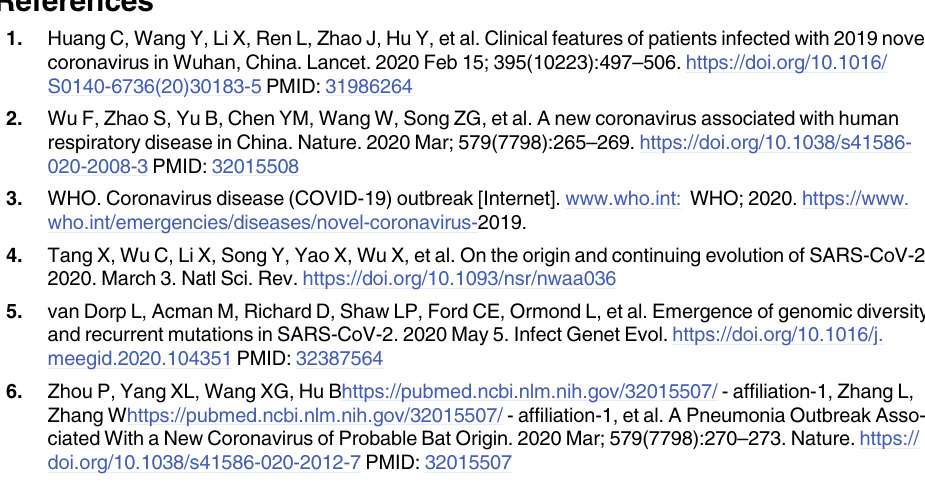
S4 Table. Evaluation of the sensitivity of the heat treatment method using different com- mercially available RT-PCR kits. S5 Table. Sensitivity assessment of the heat treatment protocol. S6 Table. Comparison of Ct values in paired samples positive in both NA/RT-qPCR and Heat